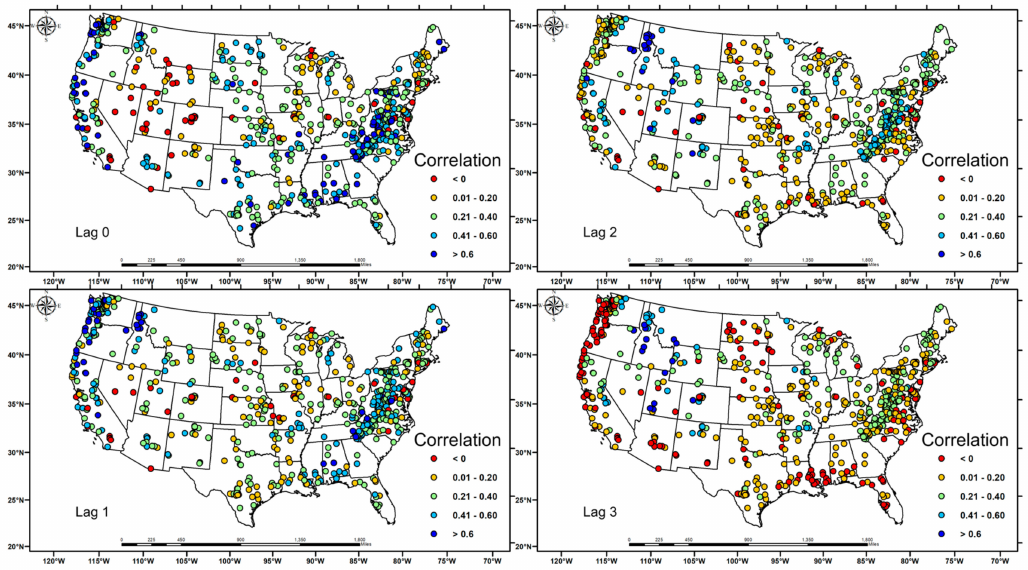
Figure 4. Spatial variation of correlation coe ffi cients of surface soil moisture-streamflow for di ff erent lag